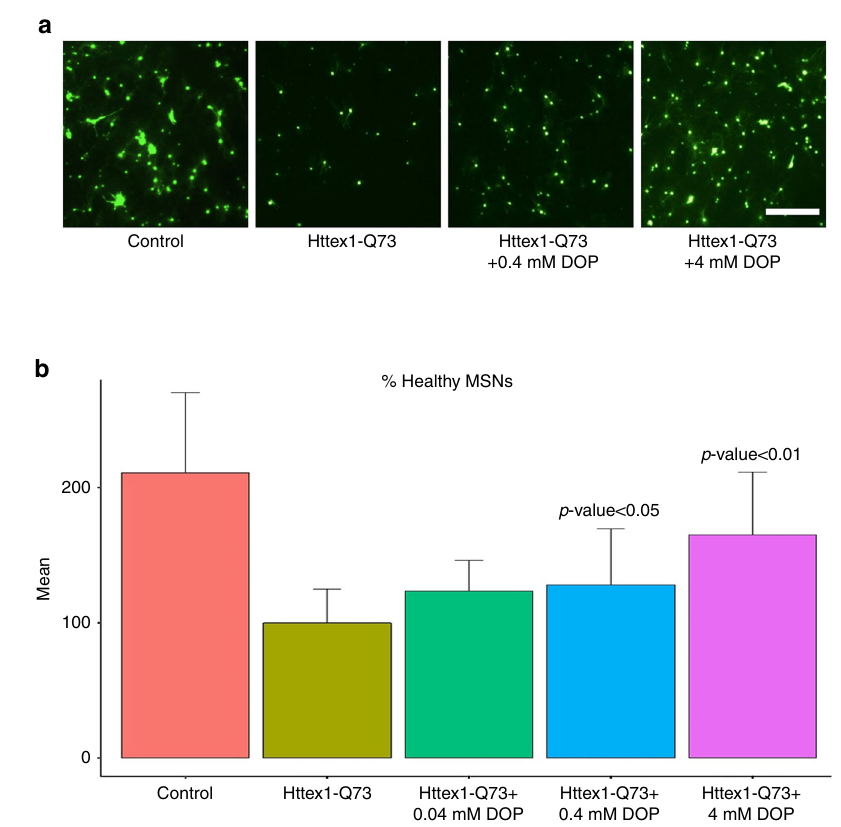
Fig. 7 Inhibiting SPL has neuroprotective effects in brain slice. a Example fl uorescence photomicrograph of live brain slices biolistically transfected with YFP to provide a marker for the quanti fi cation of healthy MSNs. The micrographs show: MSNs expressing YFP in a control brain slice ( “ Control ” ), and in brain slices co-transfected with Httex1-Q73 construct and treated with either vehicle ( “ Httex1-Q73 ” ) or different concentrations of DOP ( “ Httex1-Q73 + 0.4 mM DOP ” , “ Httex1-Q73 + 4 mM DOP ” ). Scale bar = 400 μ m. b Treating coronal brain slices with DOP signi fi cantly increases the number of detected MSNs. Graphs show the numbers of healthy YFP-positive MSNs per striatal region in each brain slice averaged across 3 independent experiments and normalized to the Httex1-Q73 negative control condition set to 100%. Statistical signi fi cance was evaluated using ANOVA followed by Dunnett ’ s post hoc comparison test at the 0.05 con fi dence levels. The bar plots show the average levels and the error bar represents the standard deviation in the